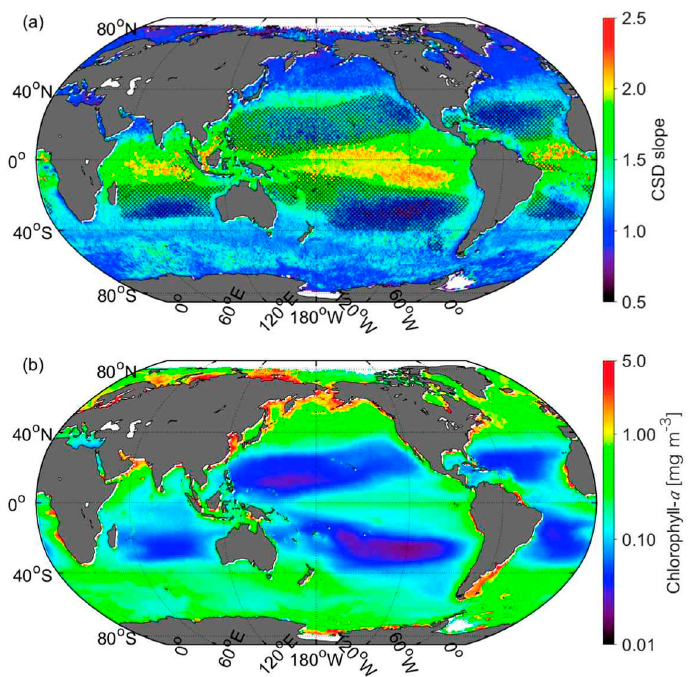
Figure 7. Global distribution of: ( a ) CSD slope; and ( b ) Chl a over 2003–2015. Cross-hatching shows